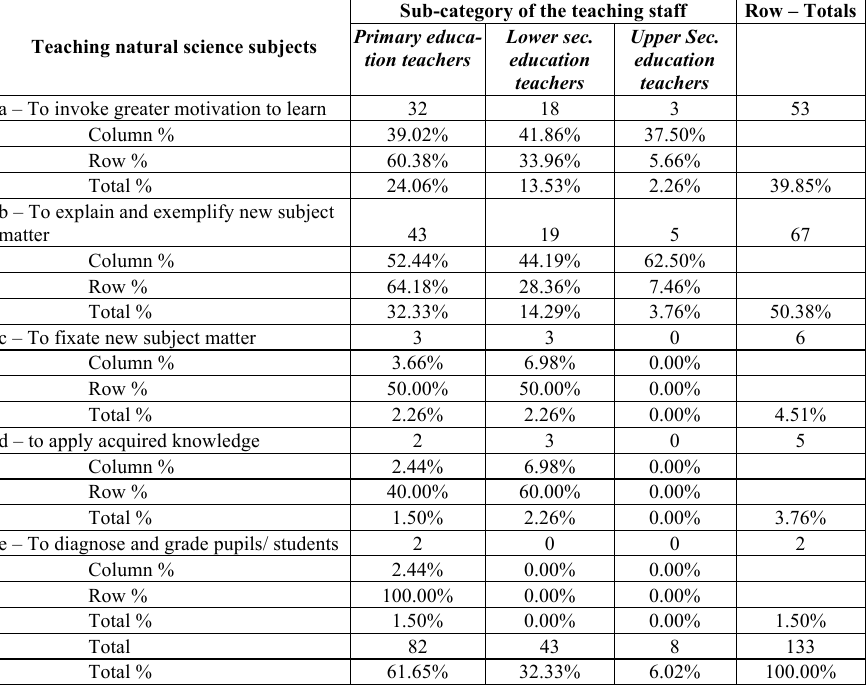
Table 2. Contingency table of the frequencies of the particular responses recorded at the stated question according to the factor sub-category of the teaching staff Sub-category of the teaching staff Row – Totals Primary educa- Lower sec. Upper Sec. Teaching natural science subjects tion teachers education education teachers